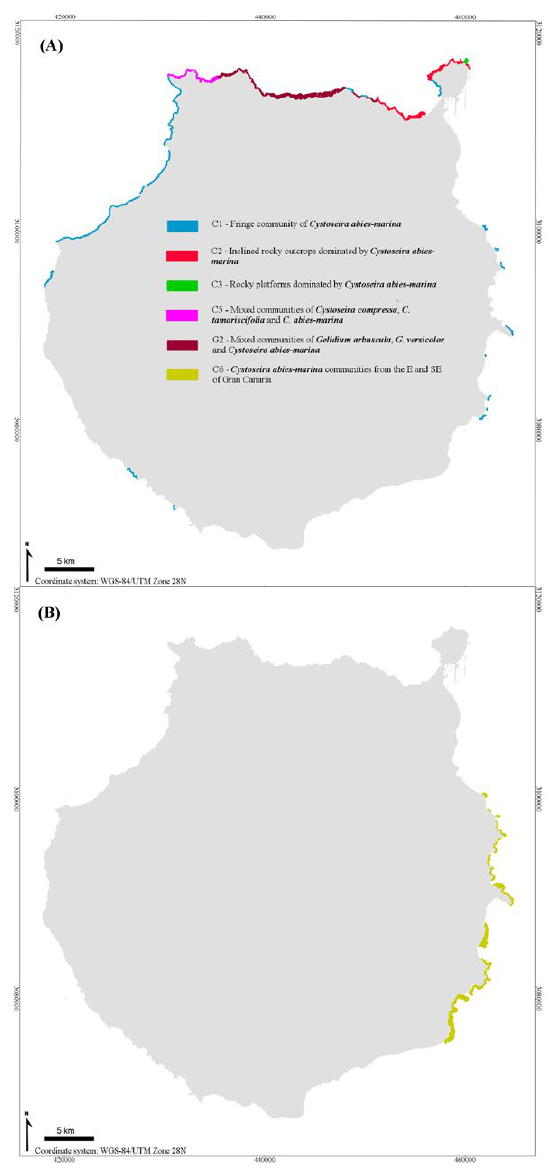
Fig. S1. – Cystoseira abies-marina communities in the 1980s, in- cluding those from Wildpret et al. (1987) (A) and from oral scien- tific communications